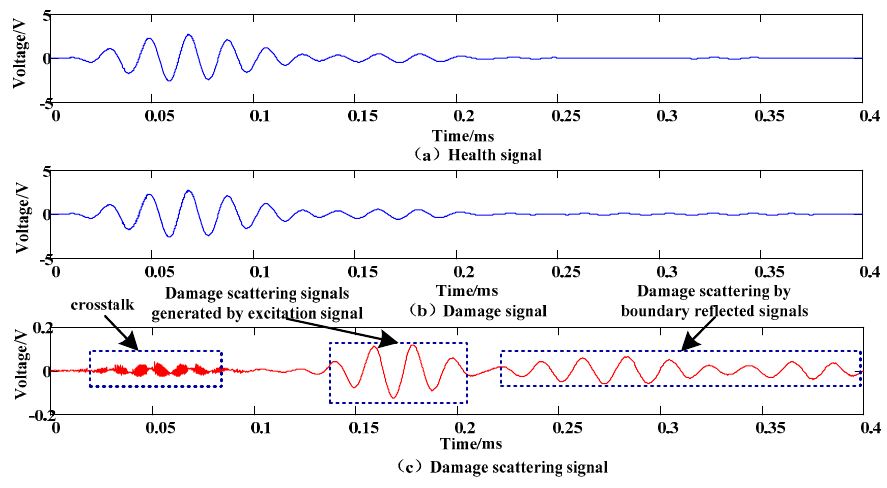
Figure 11. The sensor and damage scattering signals.